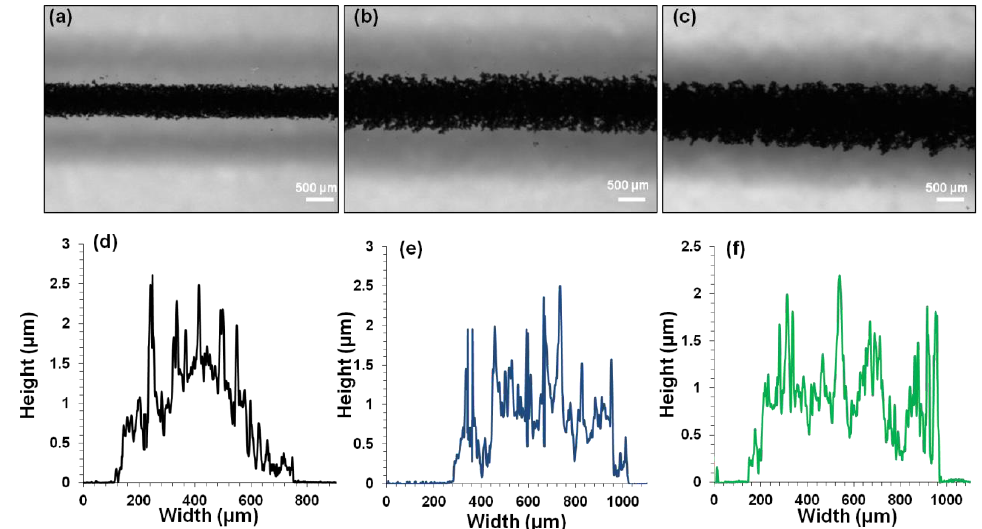
Figure 7. ( a – c ) Microscopy images of G-MWNT printed tracks 1, 2 and 3 printed layers on glass substrate. ( d – f ) Profilometry curves for 1, 2 and 3 layers of printed G-MWNT tracks on glass substrate. Area under the curve represents the cross-sectional area.